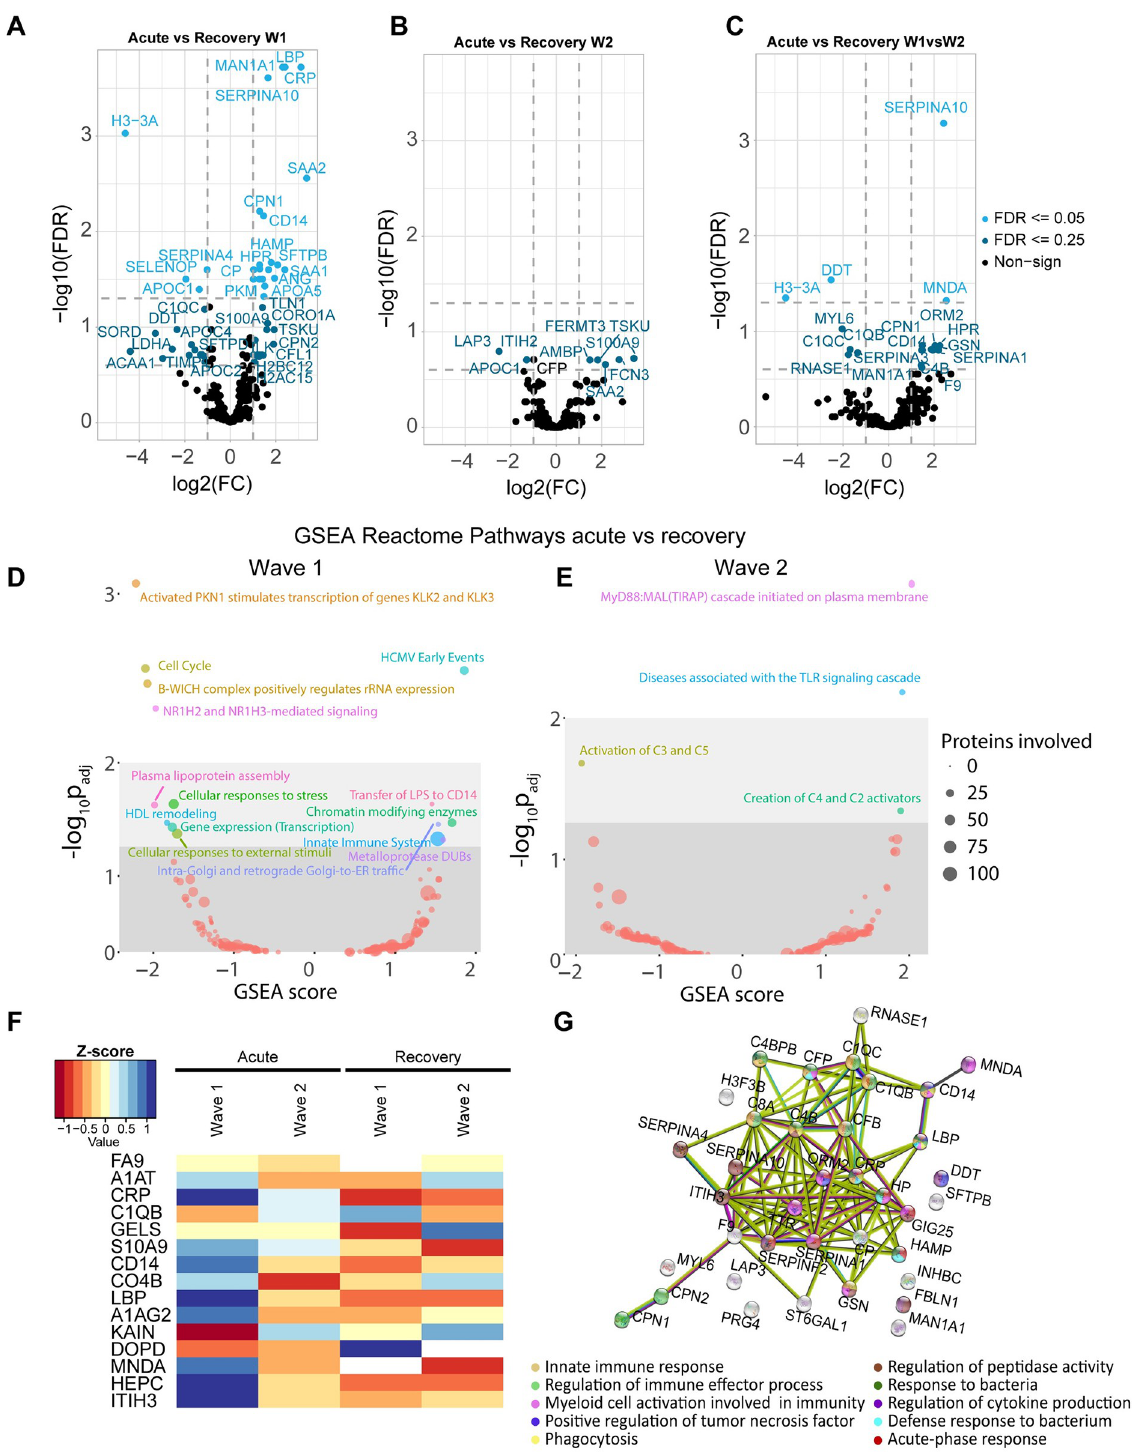
Fig 8. Plasma-protein profile evaluation for COVID-19 patients in acute- and their corresponding rec-phase between wave 1 and wave 2. (A-C ) Volcano plots depicting the changes in plasma protein intensities based on the patient condition (acute- vs rec-phase) in COVID-19 wave 1 ( A ), wave 2 ( B ) or between acute- vs rec-phase in wave 1 compared to acute- vs rec-phase in wave 2 ( C ). A minimum change of two folds and an FDR of 0.05 and 0.25 was considered for statistical significance. ( D-E ) Gene set enrichment analysis (GSEA) was done to depict changes in the expression of proteins involved in different cellular pathways using the Reactome across conditions (acute-phase vs rec-phase)